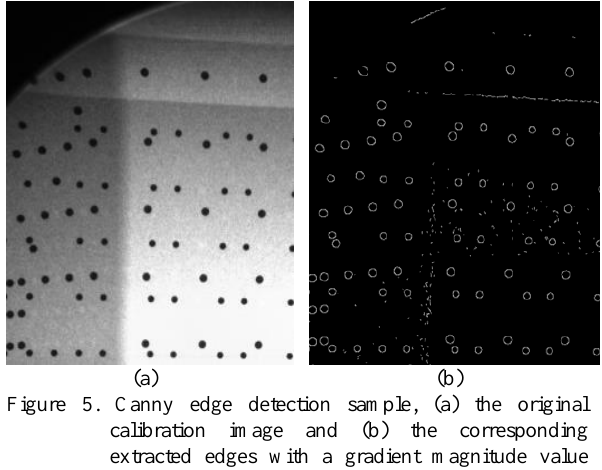
Figure 5. Canny edge detection sample, (a) the original calibration image and (b) the corresponding extracted edges with a gradient magnitude value greater than 20